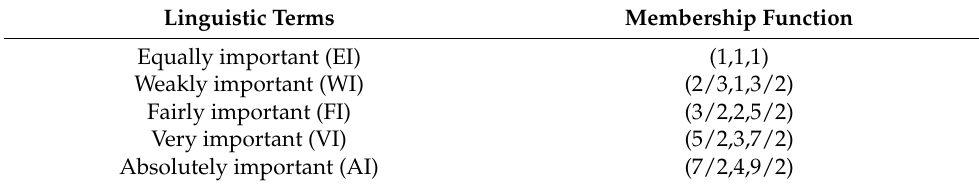
Table 1. Transformation rules of linguistic variables of